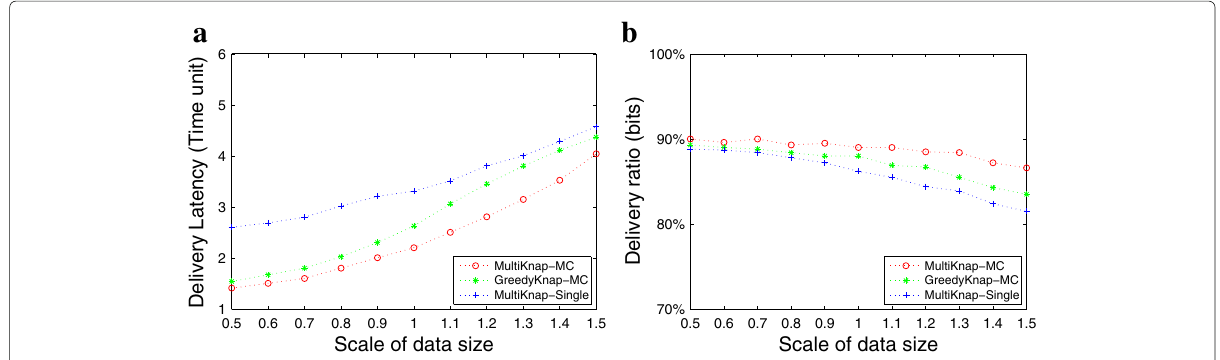
Fig. 7 Results of different scales of data file size. a Delivery delay. b Delivery